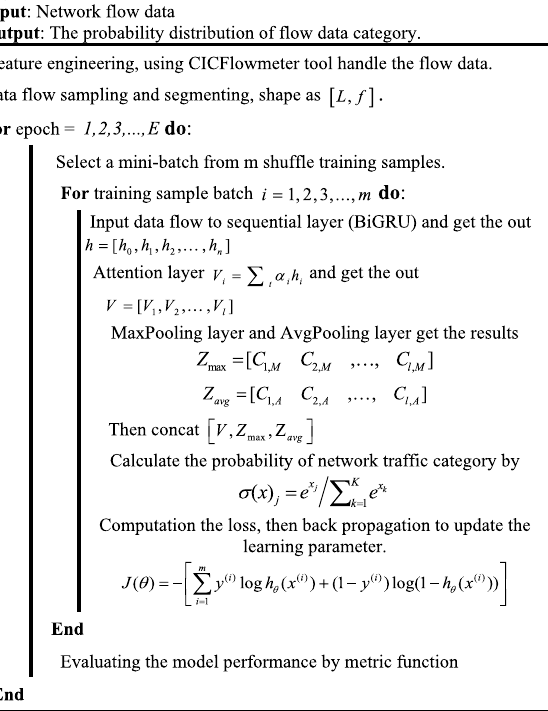
Algorithm. The attention mechanism layer enables the model to keep the computational force constant